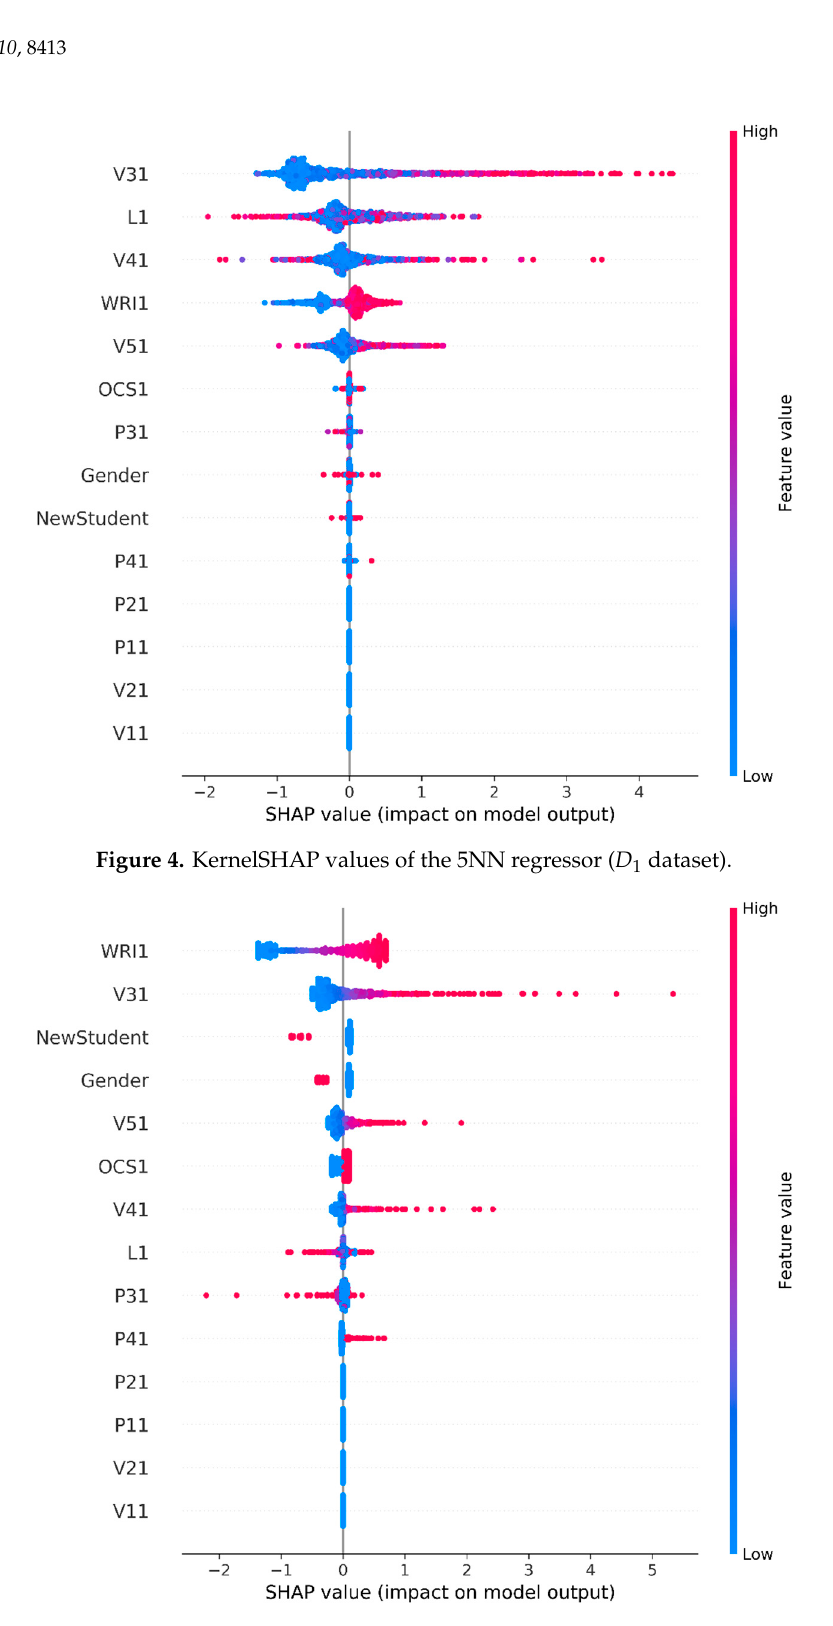
Figure 5. KernelSHAP values of the LR regressor ( D 1 dataset).